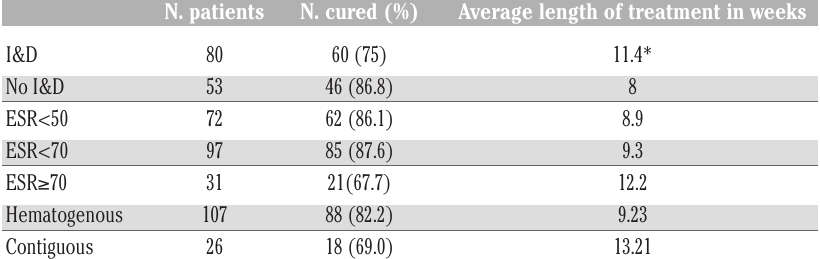
Table 3. Length of treatment and